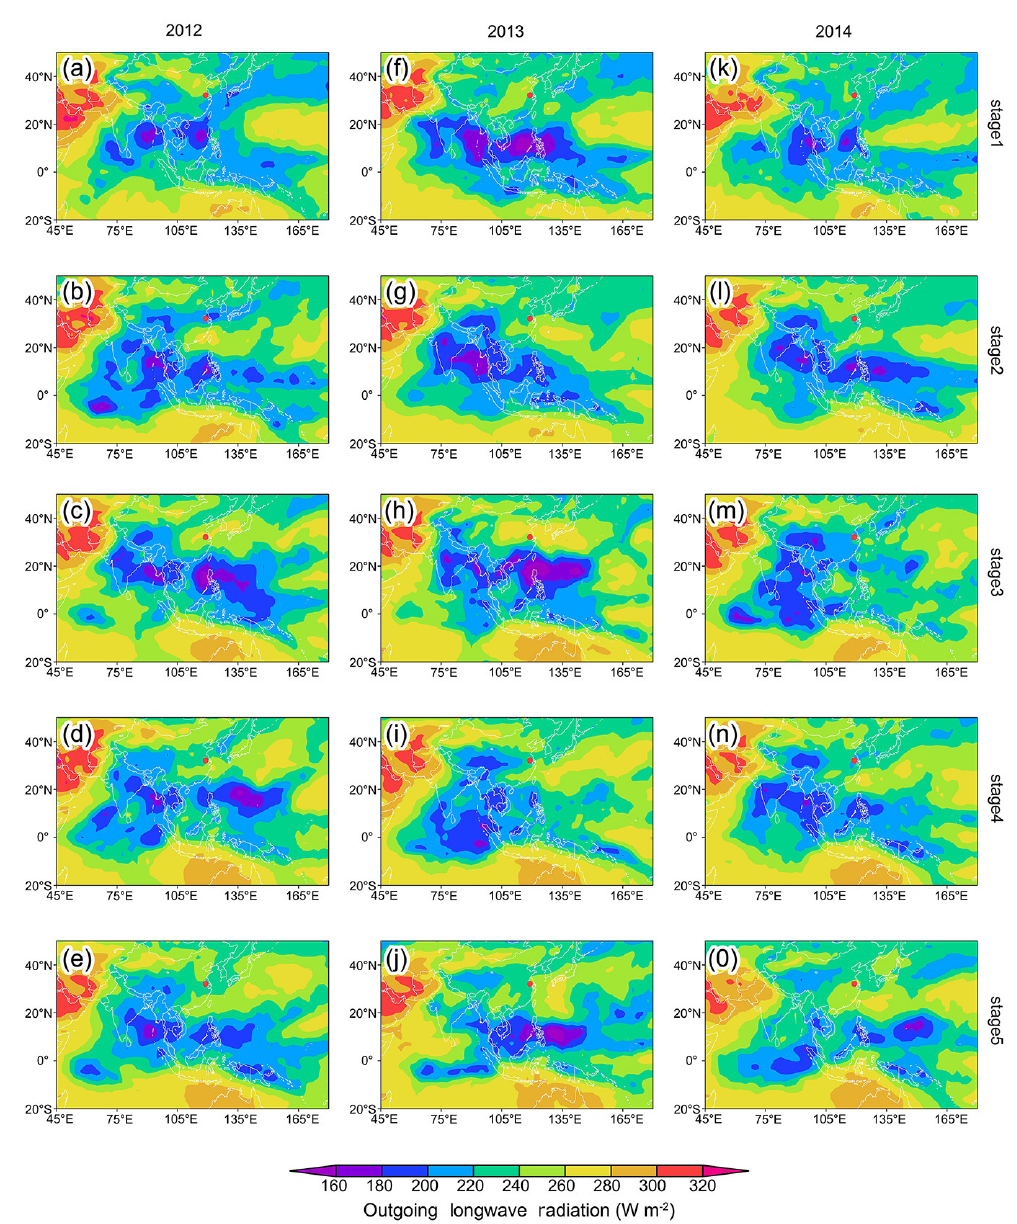
Figure 7. Composite results for average OLR (W m − 2 ) for stages 1–5 in 2012 (a–e) , 2013 (f–j) and 2014 (k–o) . The convective activity is indicated by low values in OLR. Daily OLR data at 2.5 ◦ × 2.5 ◦ resolution were used. The study site of Nanjing is marked by the red